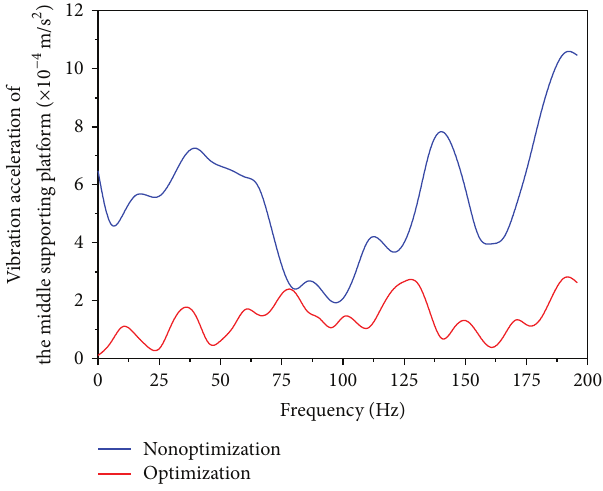
Figure 12: Vibration acceleration comparison between nonopti- mization and